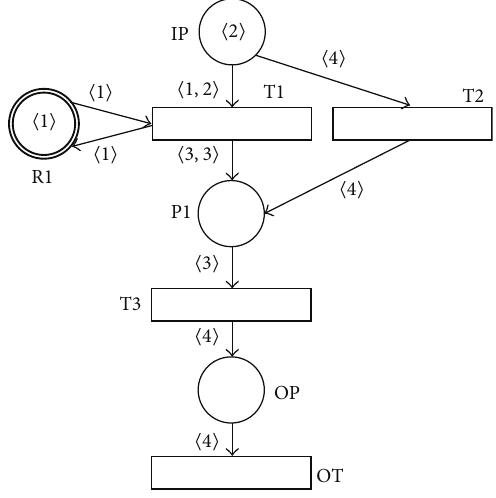
Figure 4: SNT agent net 𝑁4